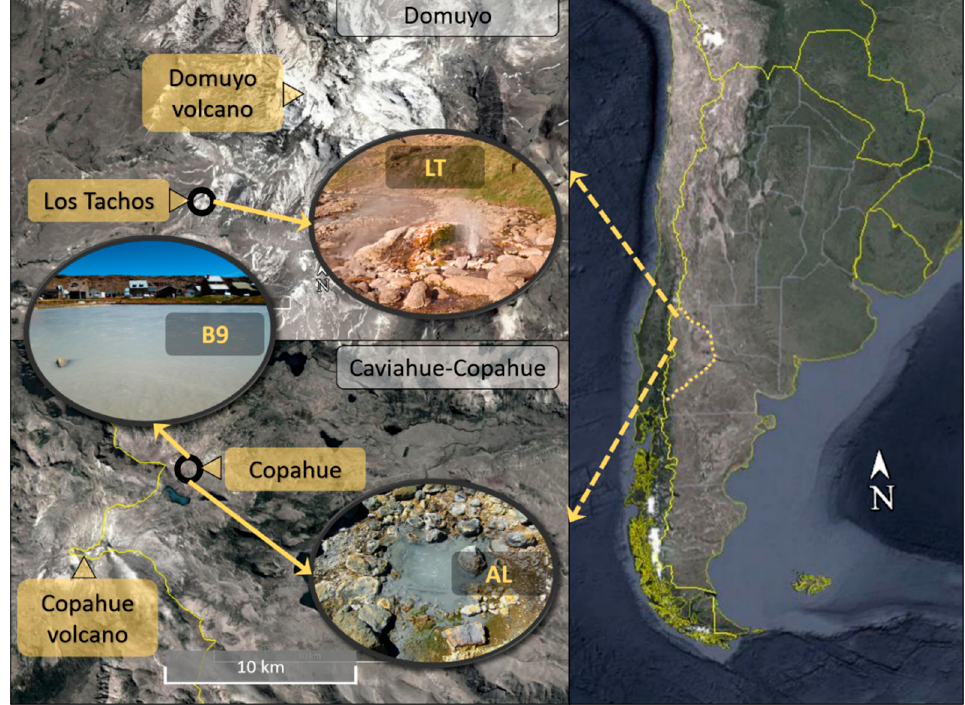
Figure 1. Location of sampling sites in Neuquén, Argentina.